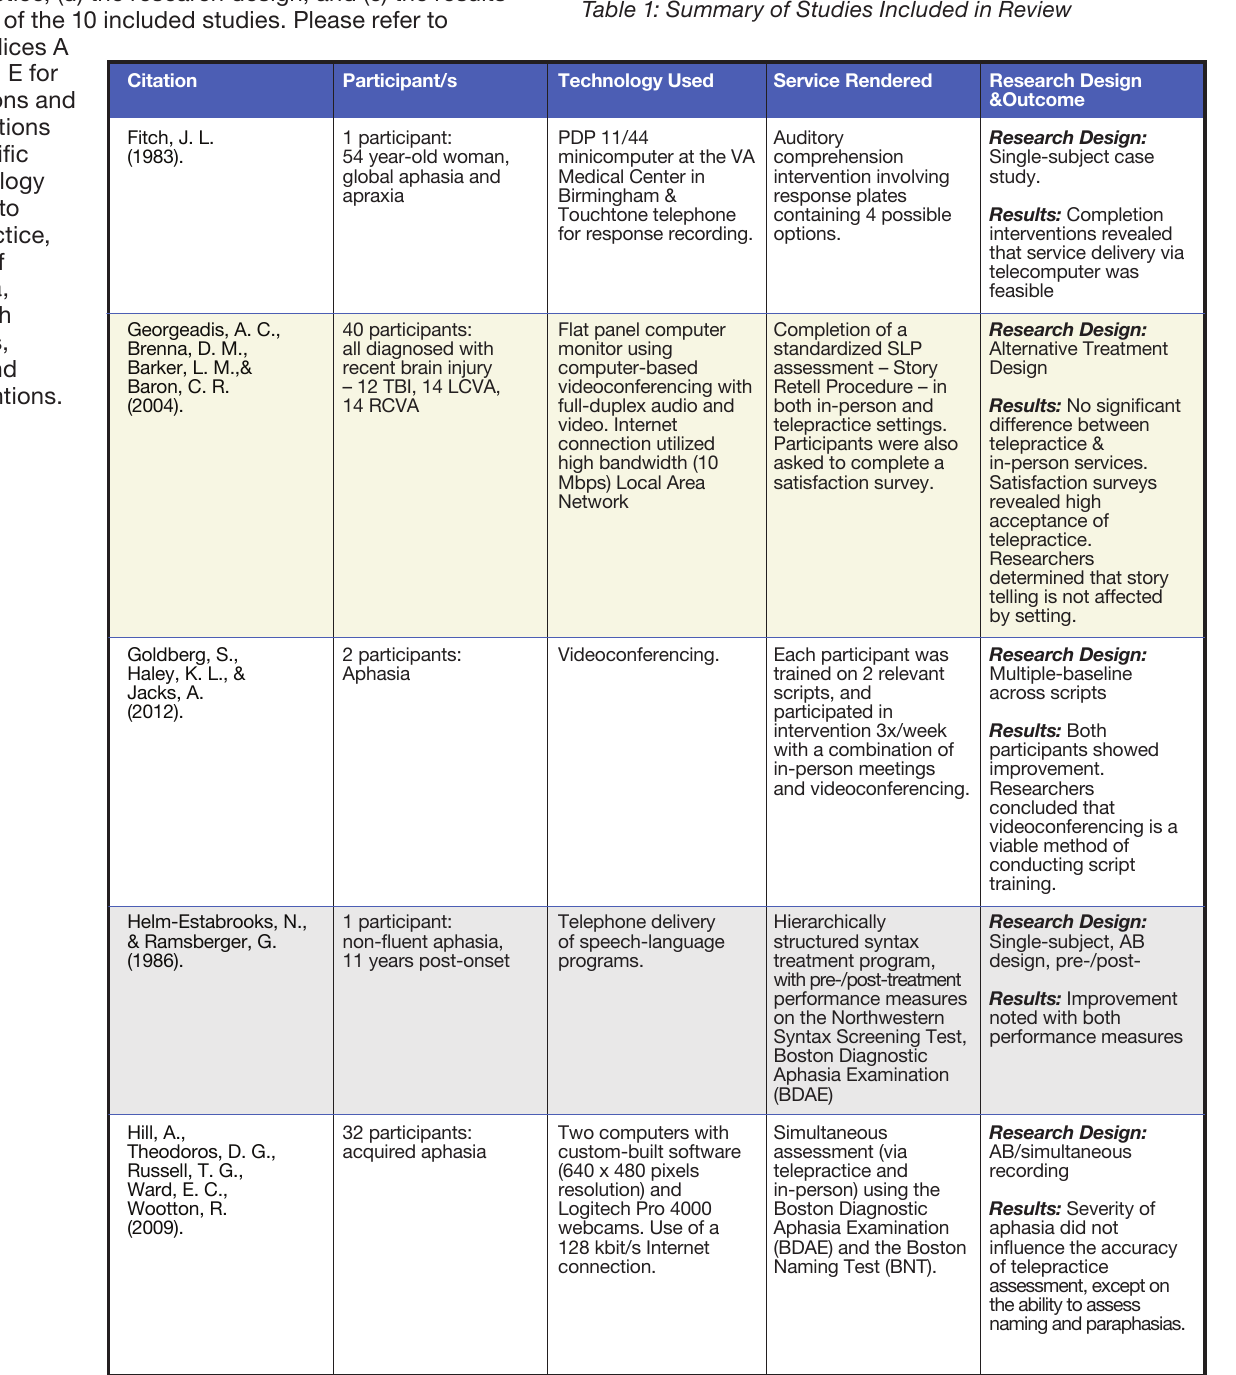
Table 1 offers a summary of: (a) the participants; (b) the technology used; (c) the services delivered via telepractice; (d) the research design, and (e) the results of each of the 10 included studies. Please refer to Table 1: Summary of Studies Included in Review